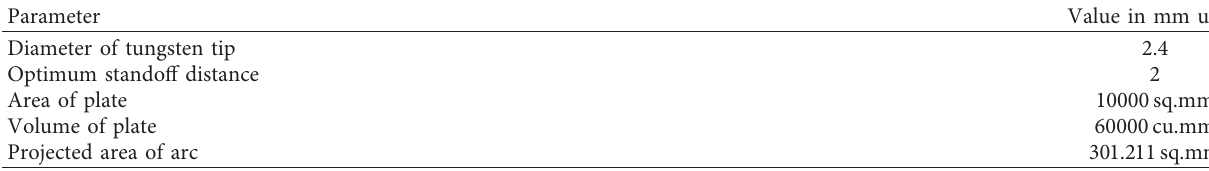
Table 6: Parameters required to calculate bead area.